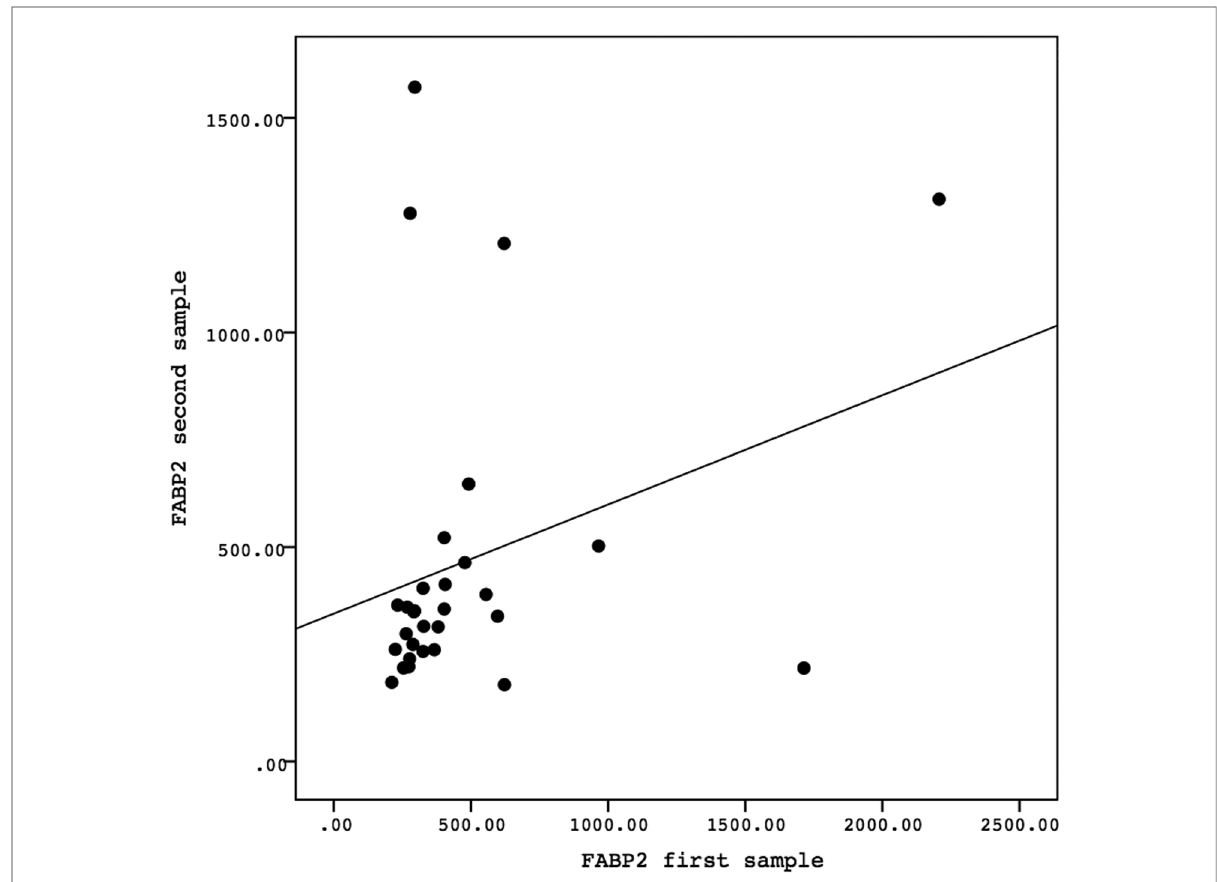
FIGURE 4 The correlation between the FABP-2 values of the fi rst sample and the second sample. Correlation analysis using Spearman correlation demonstrated the correlation coef fi cient ( r )=0.346 and P -value=0.061. FABP-2, fatty acid-binding protein-2.